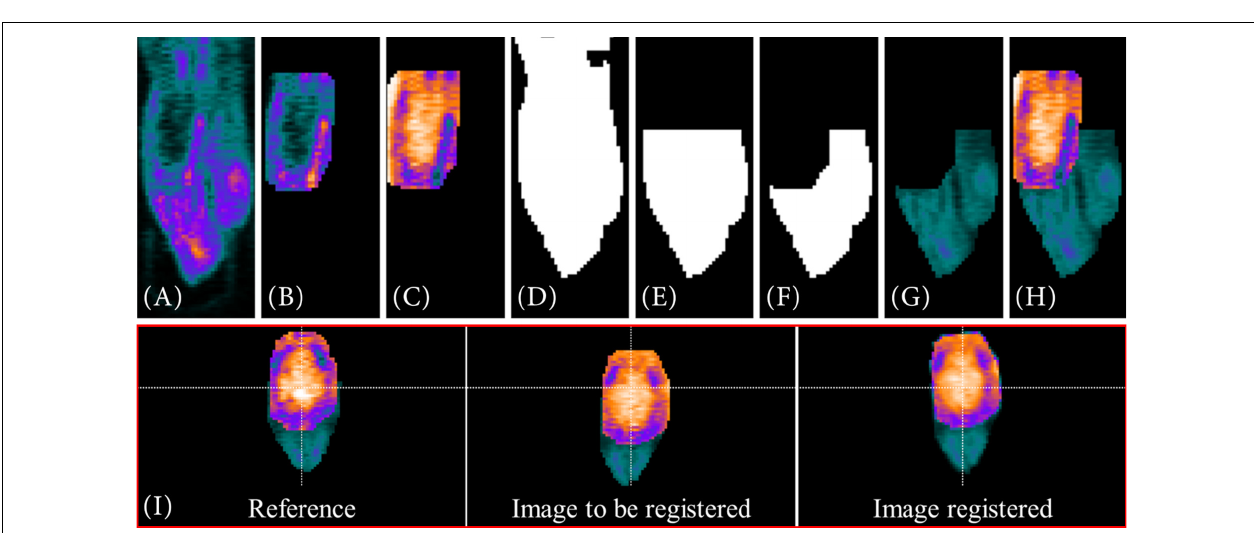
FIGURE 6 | Visualization of a “rigid” registration of two [ 68 Ga]Ga-Fucoidan images including the rat’s head for optimizing the registration process. (A–H) A description of how the head of the rat is added to the intensity-inverse VOI. Both images, reference and image to be registered, are based on a combination of intensity-inversed, segmented VOI (B,C) and rat’s head (G) . To extract the head, the image is transformed into a binary image (D) . The binary image is then reduced using the enclosing cuboid of the VOI obtained with regionprops3.m (E) . Next, the voxels already included in the VOI are excluded (F) before multiplying the reduced binary image as mask with the initial image (A) . At last, the intensity-inversed VOI (C) and the extracted head (G) are combined. (H) The result of such a VOI/addition structure combination. The lower images ( I , red box) show the result of such a “rigid”